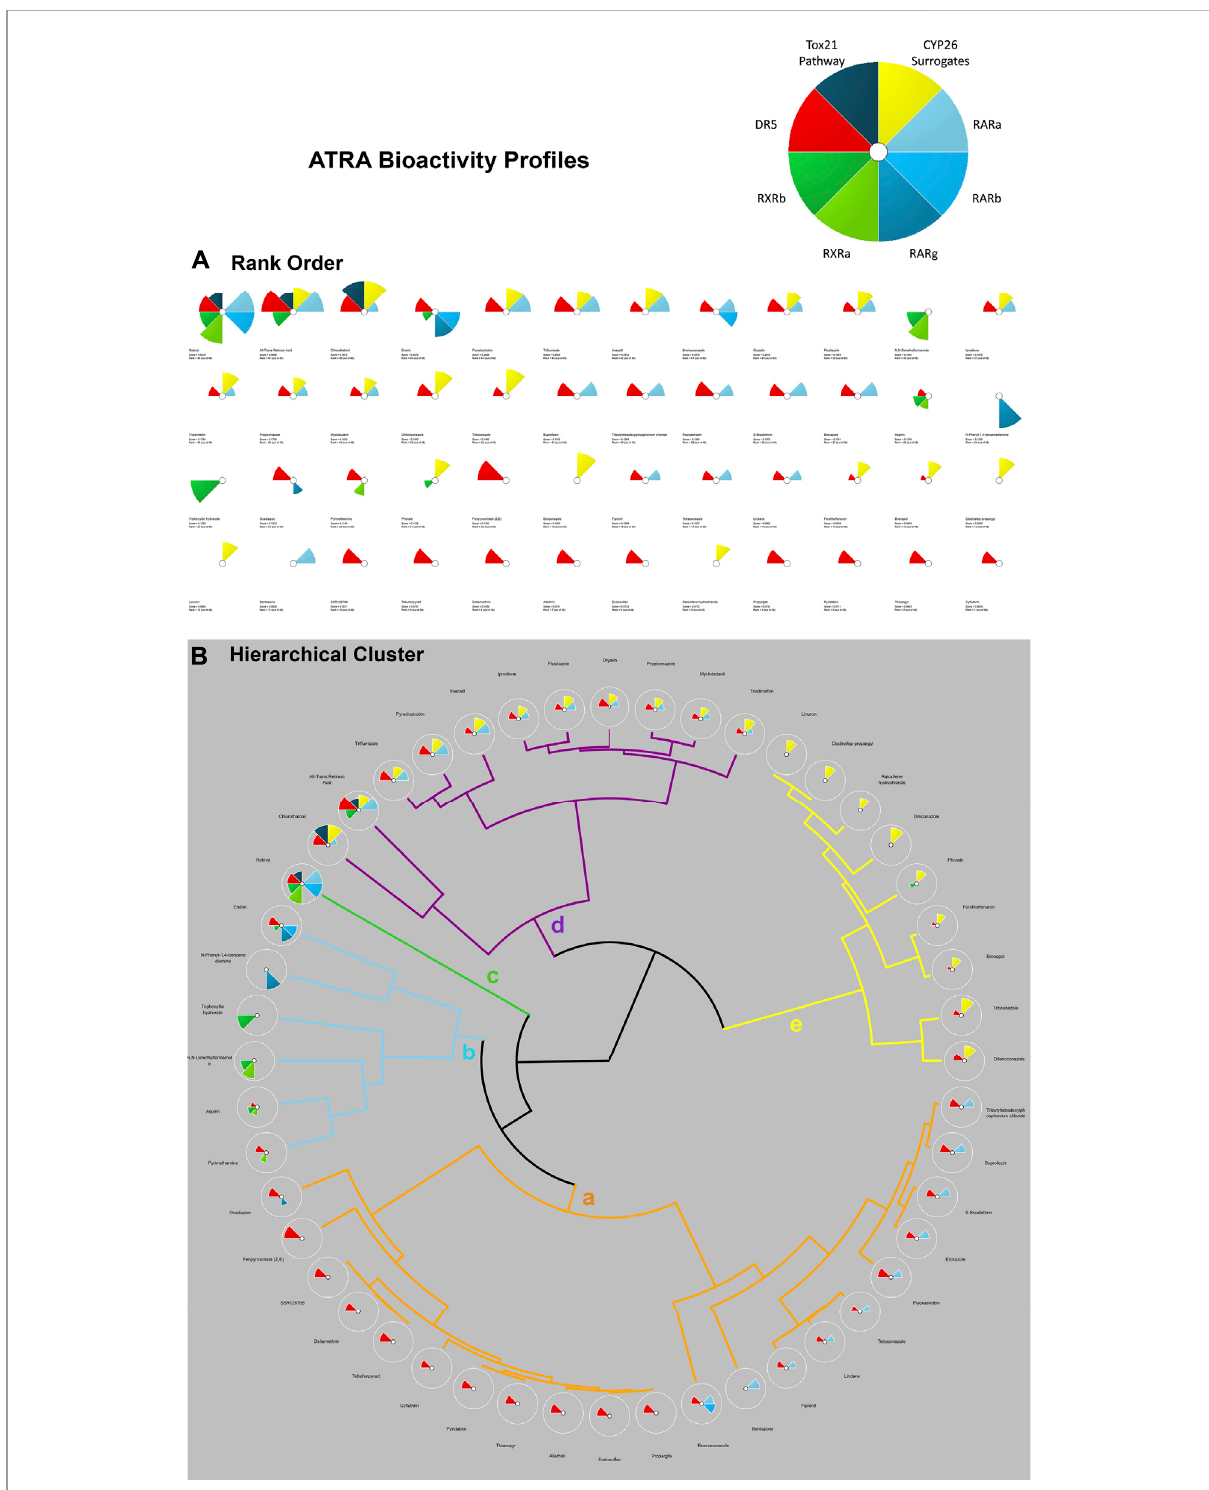
FIGURE 3 ToxPi Rank Order (A) and Hierarchical Clustering (B) results for 48 Chemicals associated with disruption of targets on the ATRA signaling pathway. The ToxPi for ATRA signaling pathway disruption target types of RARs are shades of blue, while DR5 is red, RXRs are shades of green, CYP surrogate biomarker are yellow, Tox21 is a dark teal. Targets of interest include RARA/B/C, RXR A/B, DR5, Retinol Signaling Pathway (Tox21), CYP surrogate biomarker. Most potent chemicals associated with the greatest amount of ATRA signaling target disruption have the largest